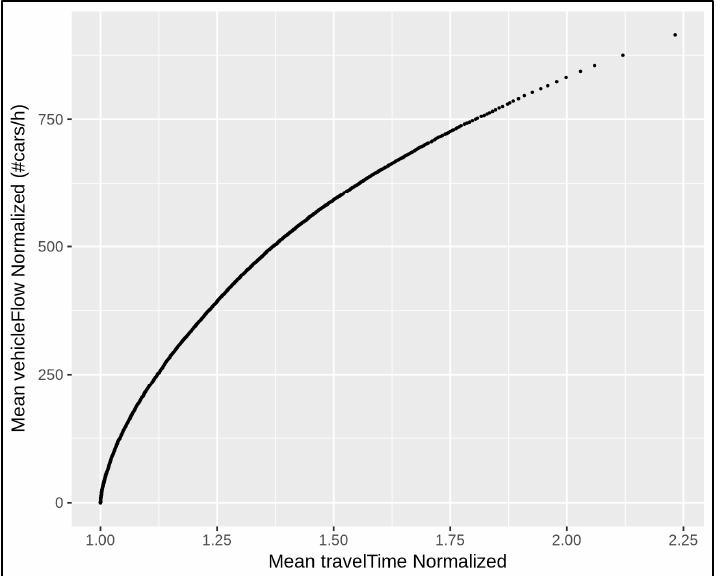
Figure 5. The average traffic trend that constitutes a mean behaviour by taking into account the different trends depicted in Figure 4.